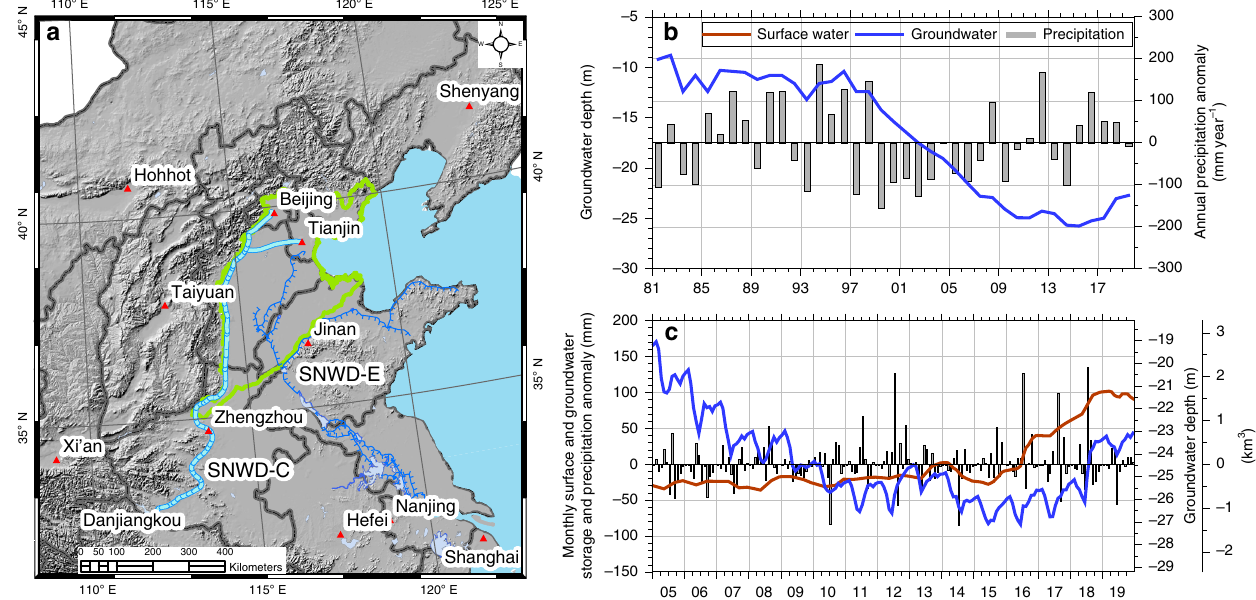
Fig. 1 SNWD routes, water storage, and precipitation in Beijing. a Central (SNWD-C, light blue line) and eastern (SNWD-E, dark blue line) routes of the SNWD (South-to-North Water Diversion), capitals of provinces and Beijing and Tianjin Municipalities (red triangles) in North China, and the NCP (North China Plain, the green polygon). The western route is still being designed and not shown. b Mean GW depths at the end of each year and corresponding annual precipitation anomalies during 1981 ‒ 2019 (the fi rst two numbers of the years are omitted in these fi gures for brevity), with a mean annual precipitation (MAP) of 540 mm year − 1 for the period. c Monthly SW and GW storage anomalies (or GW depths, see the “ Methods ” section and Supplementary Fig. 1) and associated monthly precipitation anomalies during 2005 ‒ 2019. The climatology of monthly precipitation for calculating the precipitation anomalies was derived from the 2002 ‒ 2019